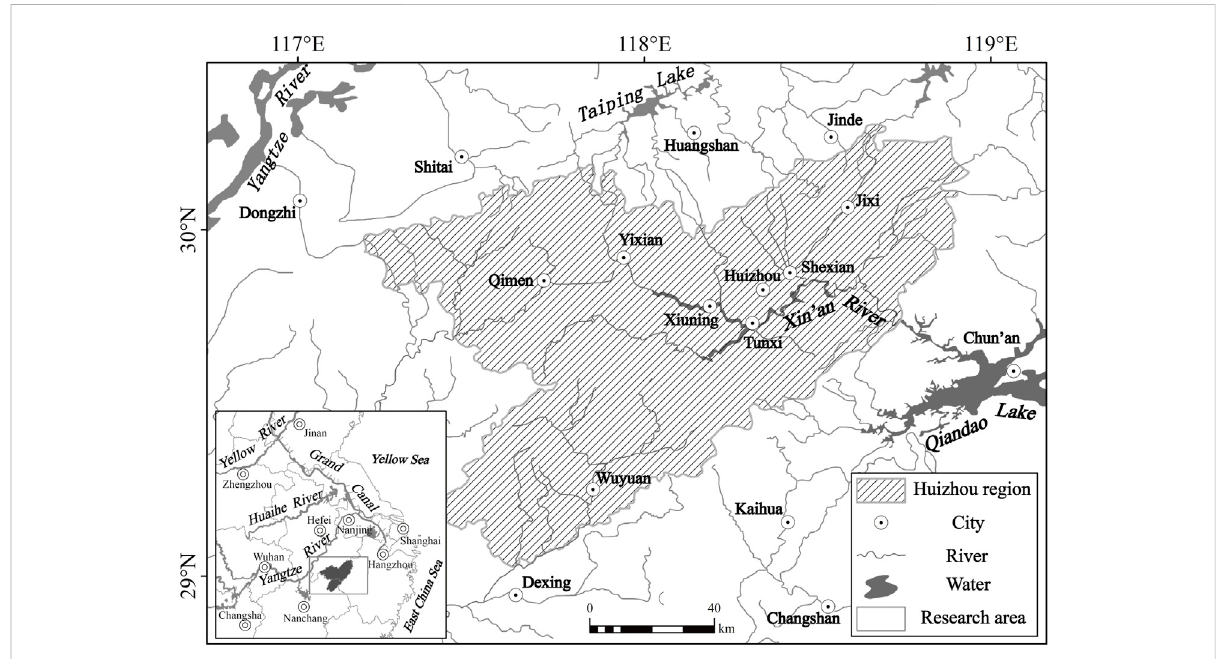
FIGURE 1 Geographic location of the Huizhou region during the Ming and Qing dynasties (1368 –